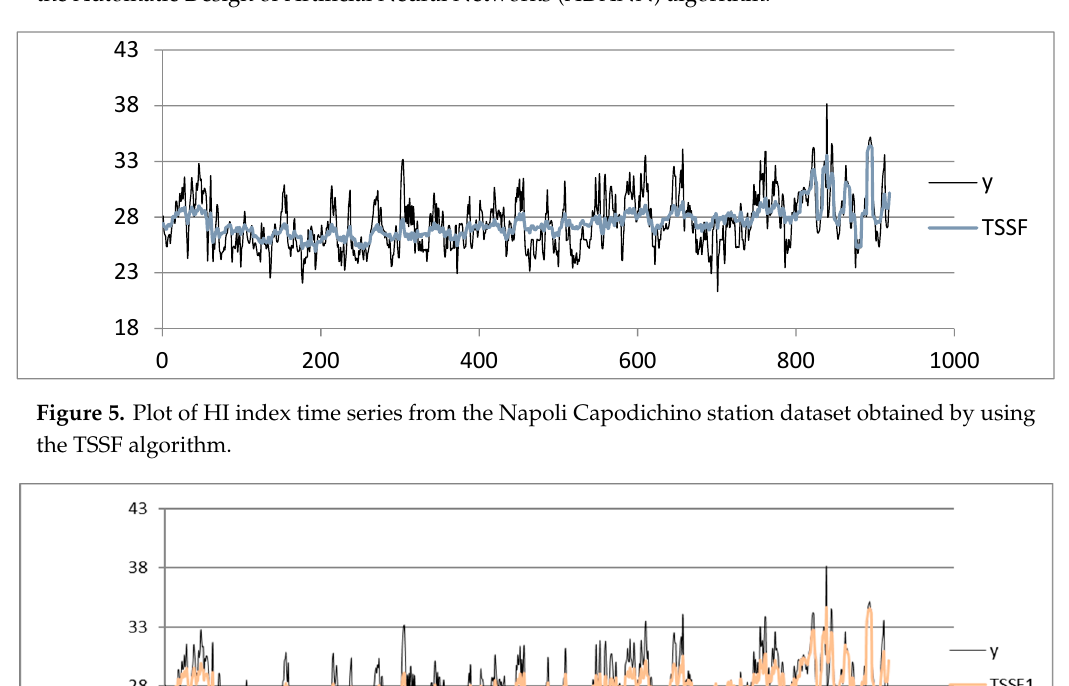
Figure 4. Plot of HI index time series from the Napoli Capodichino station dataset obtained by using the Automatic Design of Artificial Neural Networks (ADANN) algorithm.